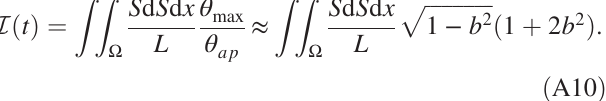
FIG. 8. Plots of the marginal energy distribution (for E b ¼ E in Eq. (48) for m 1 ¼ m 2 ¼ m 3 for different values of β : β ¼ 1 . 5 (blue line), β ¼ 1 (red, dash-dotted line), and β ¼ 2 (black, dashed line). One can see that except for at energies where f minuscule anyway, the three plots